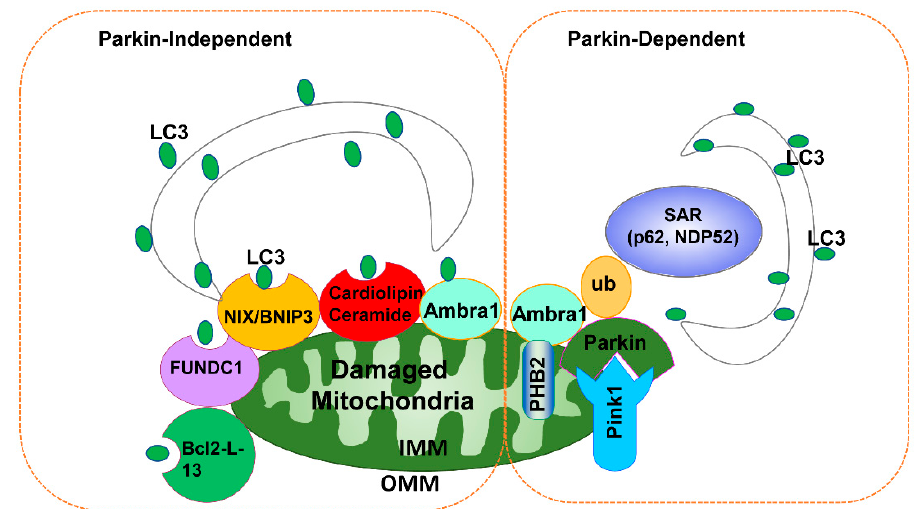
Figure 1. Parkin-dependent and Parkin-independent mitophagy. In the presence of Parkin, damaged / depolarized mitochondria (e.g., following CCCP treatment) stabilize PINK1 that recruits Parkin to the mitochondria. Once on the mitochondria, Parkin promotes ubiquitination of outer mitochondrial membrane proteins, which serve as binding partners for SAR, such as p62 or NDP52. SAR acts as an adaptor molecule through direct interaction with LC3 to recruit autophagosomal membranes to the mitochondria. The mitochondrial inner membrane protein PHB2 also binds to LC3 through its LIR domain upon mitochondrial depolarization after proteasome-dependent outer mitochondrial membrane rupture in a Parkin-dependent manner. For the Parkin-independent pathway, damaged mitochondria (particularly under hypoxia conditions) increase the expression of FUNDC1, NIX, and BNIP3, which may in turn recruit autophagosomes to mitochondria by direct interaction with LC3 through their LIR domains. Upon mitochondrial depolarization, Bcl-2-L13 also promotes mitophagy independent parkin. Upon toxin or drug-induced mitochondrial damage, mitochondrial lipid Cardiolipin and ceramide also bind to LC3 and promote mitophagy independent of Parkin. Notably, Ambra1 may promote mitophagy in both Parkin-dependent and Parkin-independent manners. IMM, inner mitochondrial membrane; OMM, outer mitochondrial membrane; SAR, soluble autophagy receptor; ub,